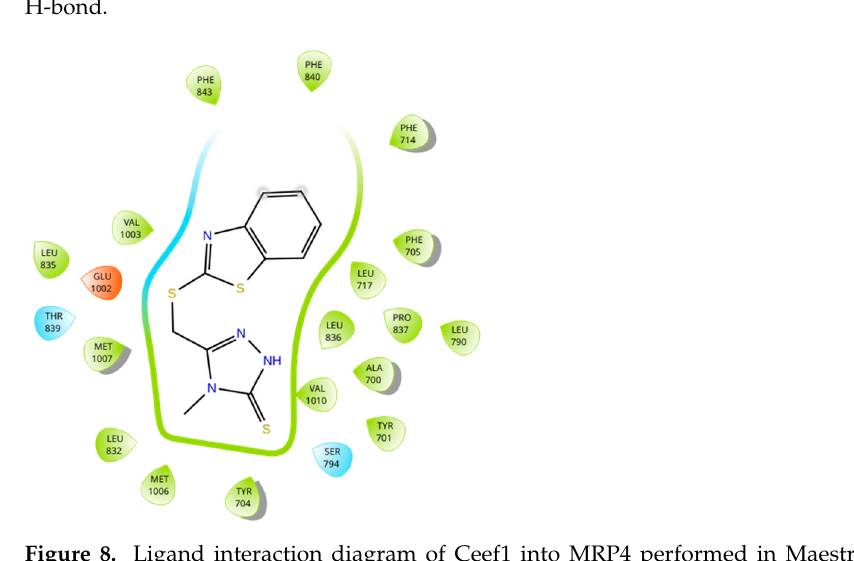
Figure 8. Ligand interaction diagram of Ceef1 into MRP4 performed in Maestro. Blue: polar interaction. Orange: interaction with negative charged residue.